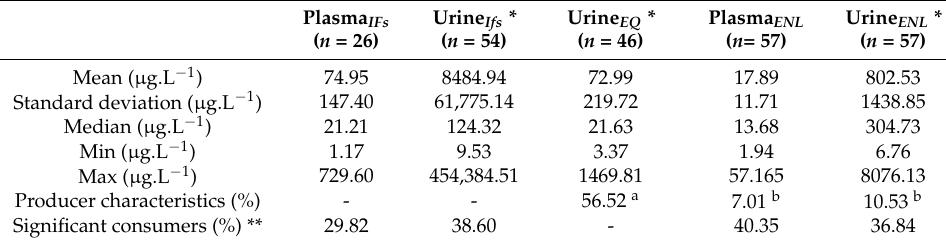
Table 1. Summary of data obtained on phytoestrogens’ concentrations for the different analyses.